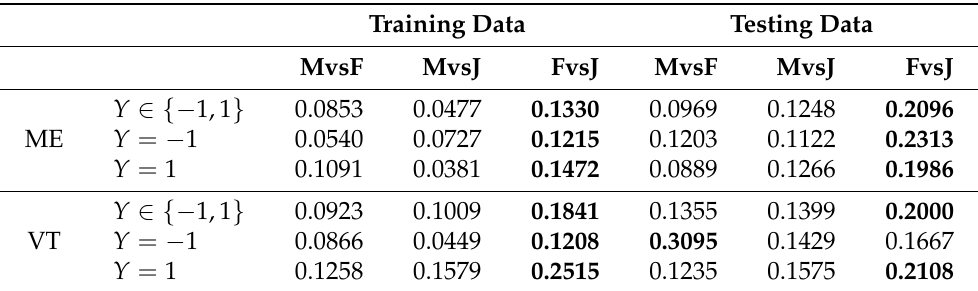
Table 8. Kolmogorov–Smirnov distances in loan amount distributions of males versus females (MvsF), males versus joint (MvsJ) and females versus joint (FvsJ). Largest distances along each row corresponding to training and testing data in